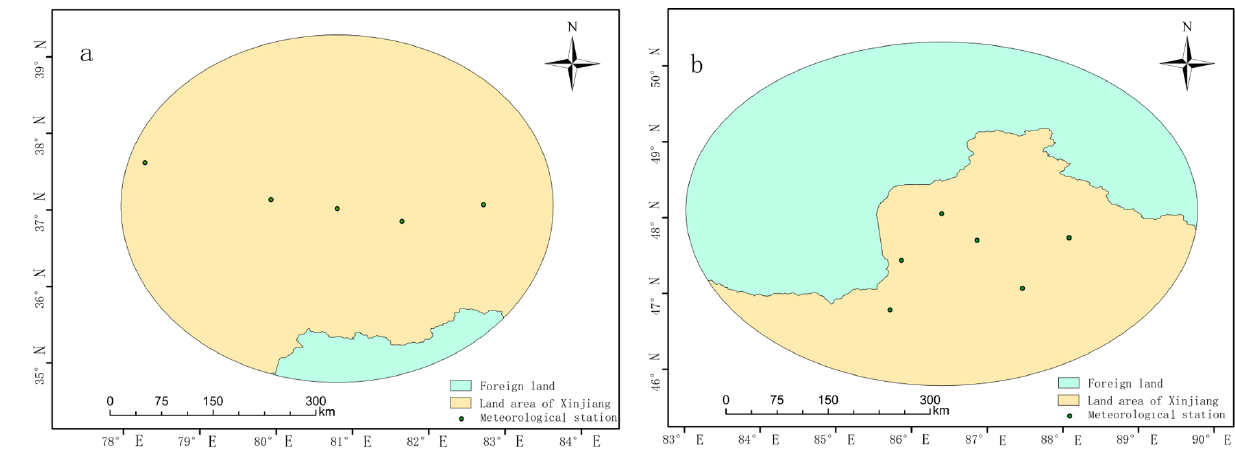
Figure 3. S 0 value of 200,000 km 2 measuring station schematic diagram of parameter value estimation (elliptic line Ω i boundary, ( a ): Cele station; ( b ): Habahe station).